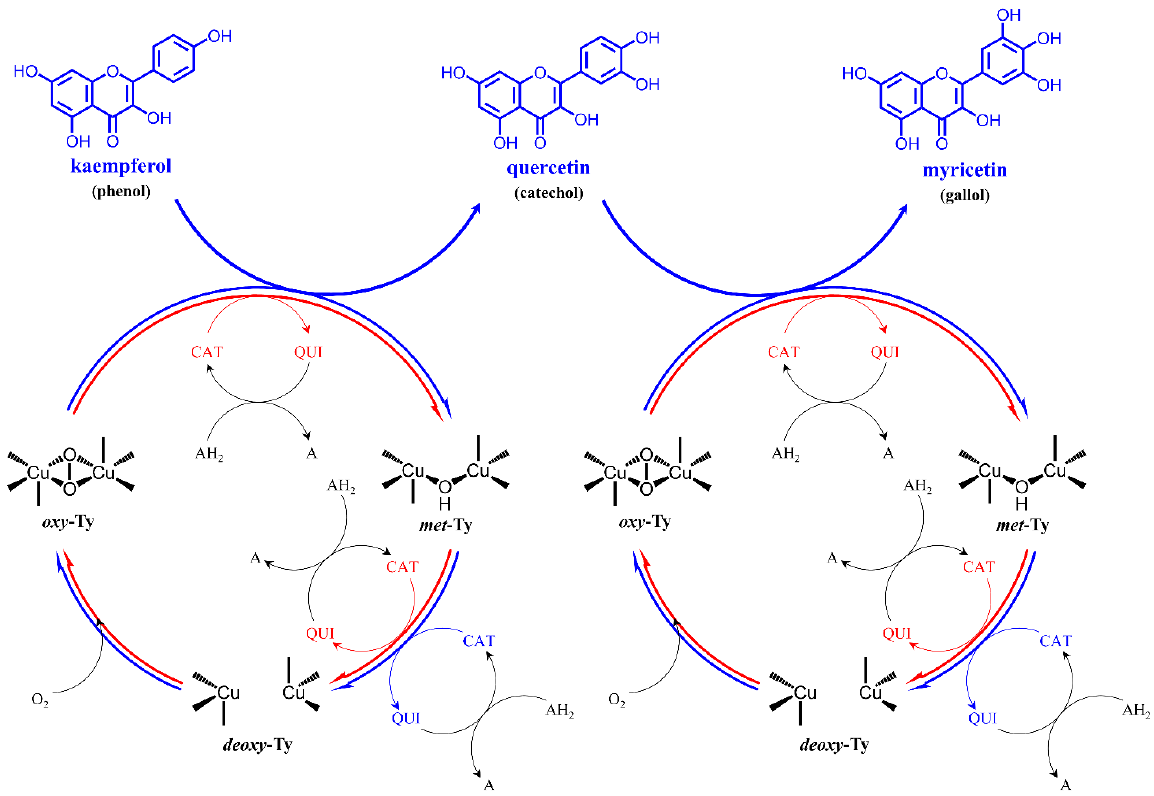
Figure 1. Schematic representation of plant polyphenol oxidation in the general tyrosinase mechanism. The two main cycles of tyrosinase, monophenolase cycle and diphenolase cycle, were represented with blue and red arrows, respectively. Some chemical species are described with abbreviations: those are: A: L-dehydroascorbic acid, AH 2 : L-ascorbic acid, Ty: tyrosinase, CAT: catechol, GAL: gallol, QUI: o -quinone.